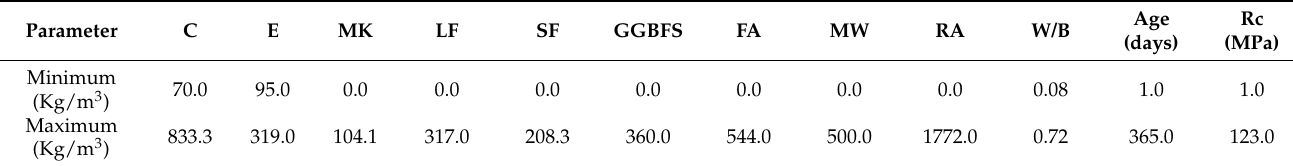
Table 3. General characteristics of concrete formulations used in the